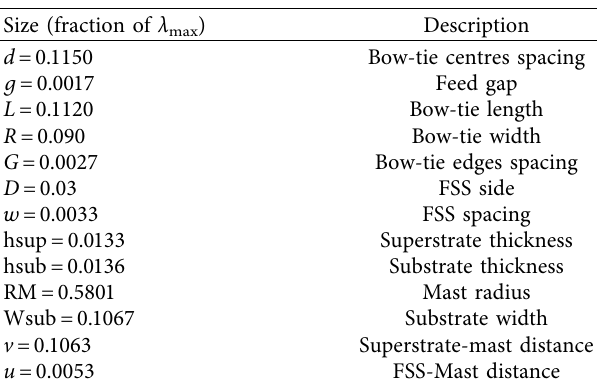
Figure 7: Array view with single bow-tie element, substrate, superstrate, FSS, and mast. The array’s main dimensions are shown. Table 2: Array